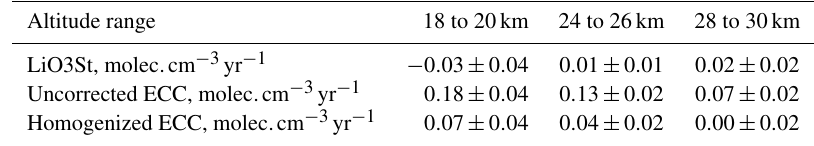
Figure 12. Interannual variation of deseasonalized O 3 concentrations in molec . cm − 3 for the uncorrected ECC (green), homogenized ECC (blue) and LiO3St (red) for 3 altitude ranges in the stratosphere: 18–20km (a) , 24–26km (b) and 28–30km (c) . The regression lines through all the O 3 anomalies between 1995 and 2020, O 3 trends (in molec . cm − 3 yr − 1 ) and their uncertainties with a 95% confidence are shown in each panel. Table 2. Stratospheric trends and their confidence limit for lidar, uncorrected ECC and homogenized